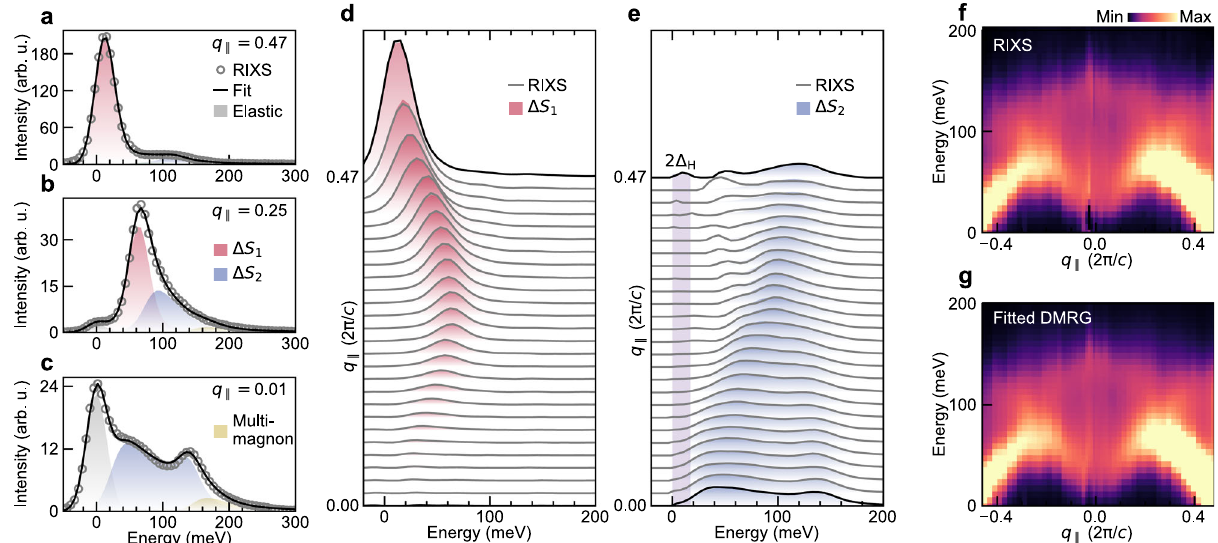
Fig. 3 Magnetic excitations probed by RIXS in Y 2 BaNiO 5 at Ni L 3 -edge. Representative RIXS spectra at q ∥ = a , 0.47, b , 0.25, and c , 0.01 with fi ts using spin susceptibilities obtained from DMRG (see Methods). Note that an additional peak is included in the fi ts in panel c to account for a multimagnon spectral tail around 200 meV, which may originate from higher-order contributions not considered in the expansion of the RIXS response. d RIXS line spectra after subtraction of elastic, Δ S 2 and the high energy tail structure visible in panel c . Shaded areas are fi tted pro fi les from DMRG for Δ S 1 . e RIXS line spectra after subtraction of elastic, Δ S 1 and the high energy tail structure visible in panel c . Shaded areas are fi tted pro fi les from DMRG for Δ S 2 . The vertical shaded bar represents twice the Δ H value from ref. 5 . f Experimental RIXS intensity map with elastic contribution subtracted. g DMRG intensity map with summed contributions from Δ S 0 , Δ S 1 and Δ S 2 excitations determined by fi tting experimental RIXS spectra using Eq.